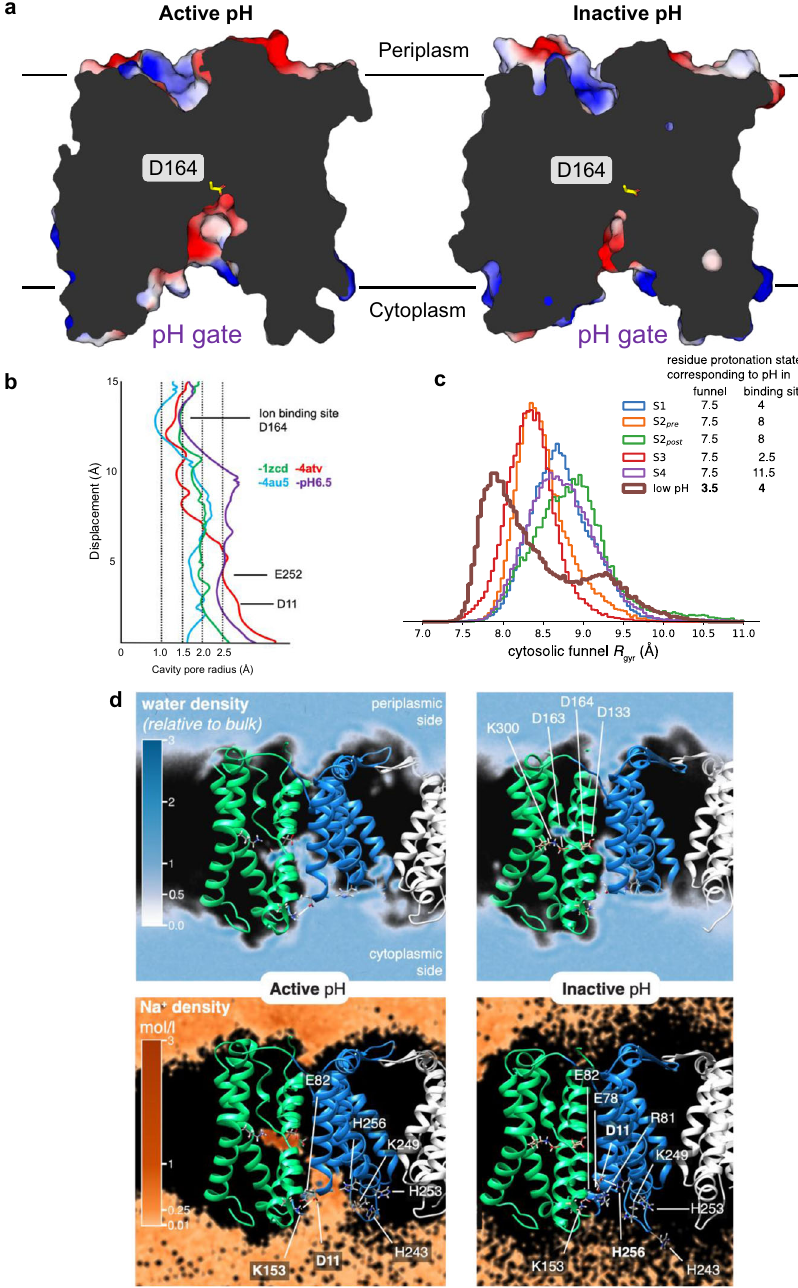
Fig.2|SolventaccessibilityanalysisbetweeninactiveandactivepHstructures. a Slice through anelectrostaticsurface representation of NhaAstructuresat active pH 6.5 (left, PDB ID: 7S24) and inactive pH 4.0 (right, PDB ID: 4AU5). The ion- binding aspartate is indicated and shown as yellow sticks. Notably the ion-binding funnel open to the cytoplasmic side is much more open at active pH. b HOLE analysis of the cytoplasmic funnel of NhaA crystal structures. c Opening of the cytosolicfunnelinMD simulationsasestimatedbythedistributionoftheradiusof gyration of the funnel-lining pH sensor residues. In the low pH simulation (brown)